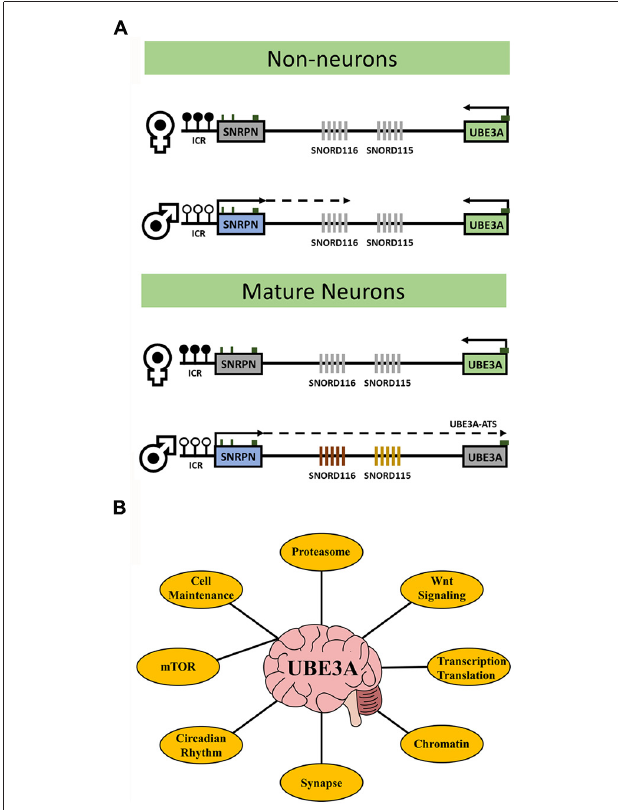
FIGURE 1 | UBE3A transcriptional regulation and key related pathways. (A) The diagrams outline the expression and imprinting status of UBE3A . Maternal-specific methylation of the imprinting control region (ICR) upstream of SNRPN is represented by filled circles. Paternal-specific expression and transcriptional elongation through the locus results in the expression of the UBE3A antisense transcript ( UBE3A-ATS ) that is responsible for UBE3A imprinting. In neurons, paternal expression of SNRPN through UBE3A leads to transcription of the SNORD116 and SNORD115 clusters and induces UBE3A silencing via the UBE3A-ATS . In non-neurons, paternal SNRPN transcription does not progress to transcribe the UBE3A-ATS and UBE3A is expressed biallelically (note that non-neuronal transcription of paternal SNRPN stops upstream of SNORD116 in mice but stops just downstream of SNORD116 in human). White circles indicate unmethylated ICR, black circles indicate methylated ICR, green boxes indicate location of CpG islands, and gray fill indicates unexpressed genes. (B) The major processes affected by altered UBE3A levels in neurons discussed in this review. UBE3A has diverse functions and no single mechanism explains the phenotypes observed in UBE3A-related disorders. Understanding how these processes are connected via UBE3A my be key for therapeutic